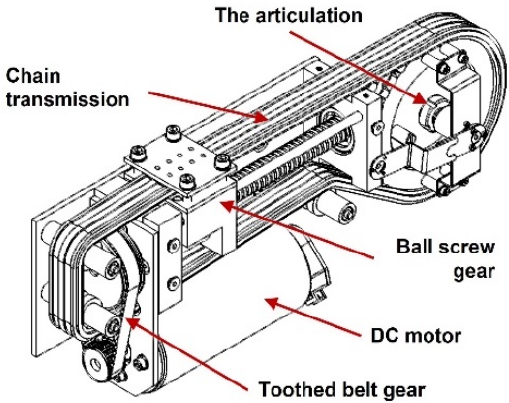
Figure 5. Structure of the drive module with a ball screw.